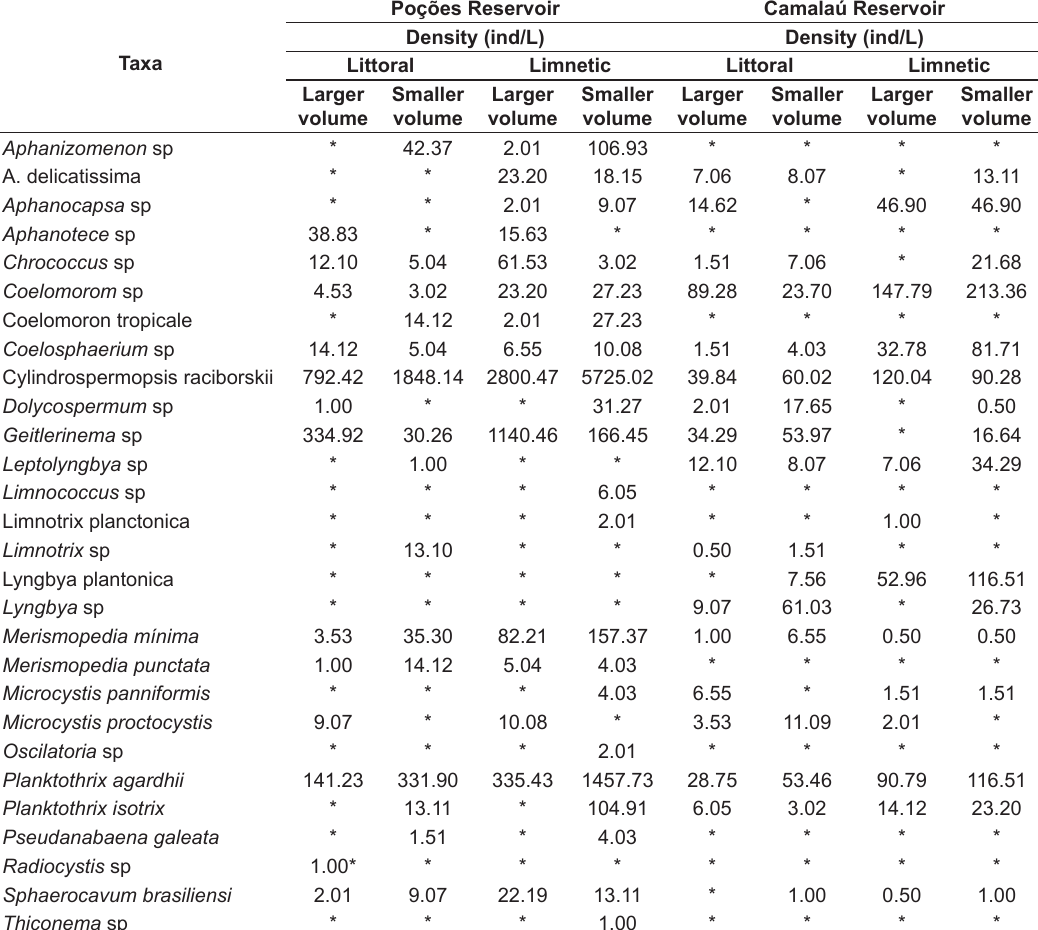
Table 4. Taxa of the Cyanobacteria community. Values of density (individuals/L) in the zones and sampling periods, in Poções and Camalaú reservoirs, Paraíba River basin, State of Paraíba, Brazil.